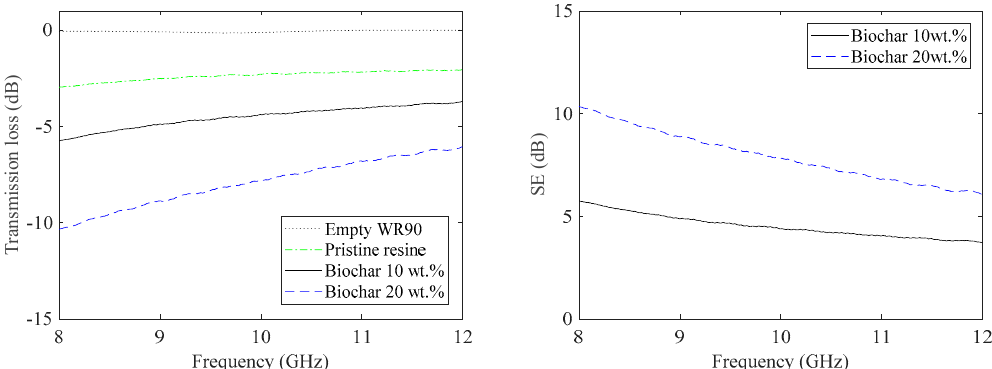
Figure 9. Transmission loss versus frequency of composites with thermal annealed sludge biochar ( left ). Shielding effectiveness of biochar composites ( right ).